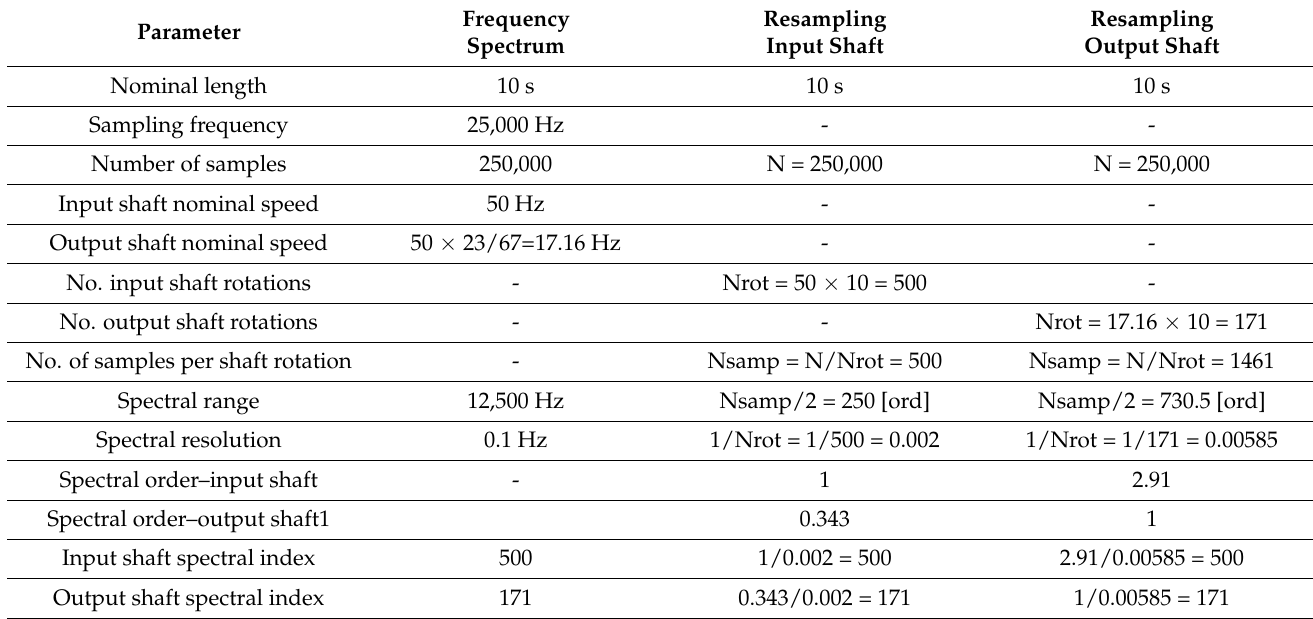
Table 1. Selected spectral